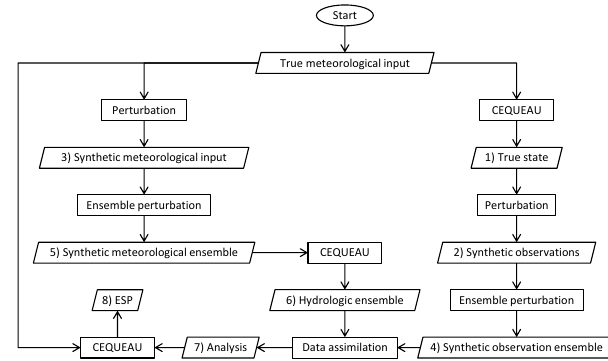
Figure 3. Flowchart for the production of ensemble streamflow pre- dictions obtained from various data assimilation